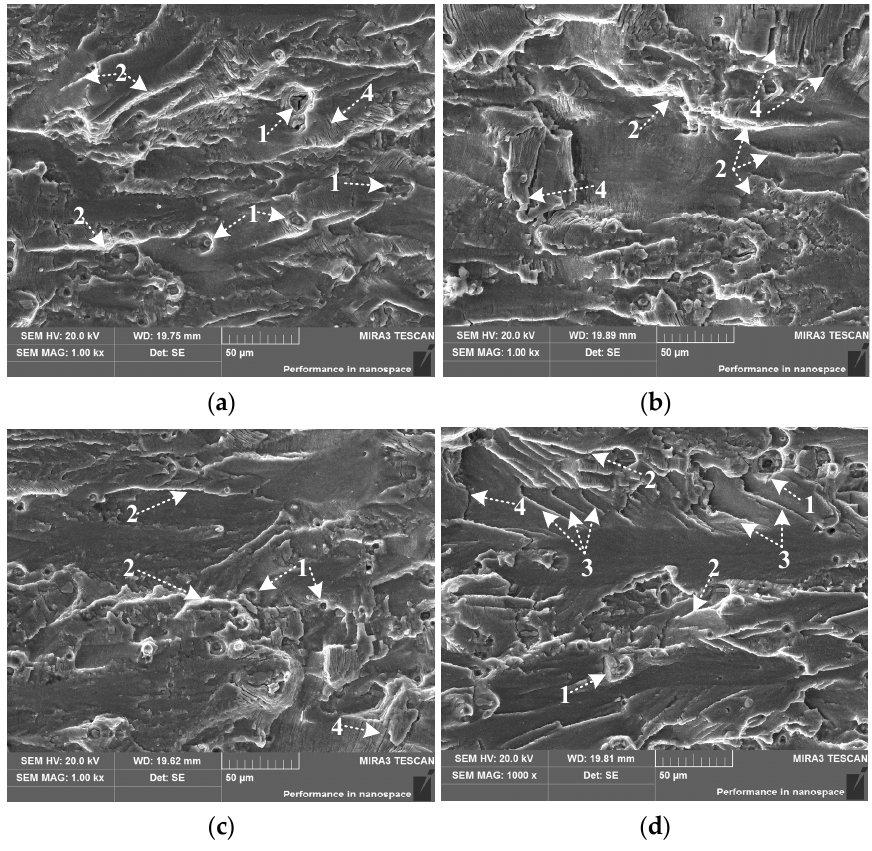
Figure 4. SEM images of stable fatigue-crack propagating zone at different creep-aging temperatures ( a = 5 mm): ( a ) 100 ◦ C—9 h; ( b ) 130 ◦ C—9 h; ( c ) 160 ◦ C—9 h; ( d ) 180 ◦ C—9 h. Marks in the figure: 1—micropore; 2—tear edge; 3—shear edge; 4—secondary crack.